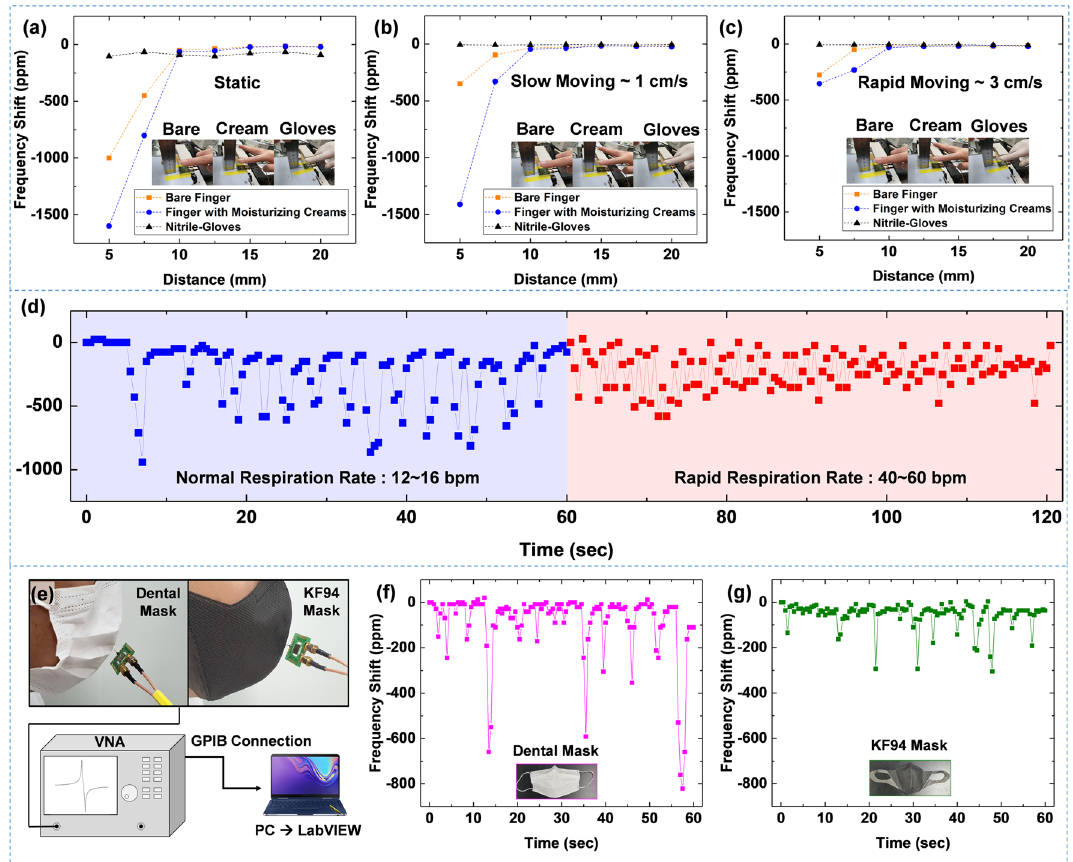
Figure 6. The frequency responses of the SAW 250 MHz_10 min sensor at different distances between the finger and sensor. The three kinds of the finger (i.e. bare finger, finger with moisturizing creams, and finger with nitrile gloves) are prepared. The sensors are tested at different speeds of finger motion, which are ( a ) static, ( b ) slow-moving (1 cm/s), and ( c ) rapid-moving (3 cm/s). ( d ) The monitoring of respiration rates using SAW 250 MHz_10 min sensor. ( e ) The schematic diagram of the experimental setup for testing salvia droplet filtration efficacy with face masks (dental mask and KF 94 mask). The frequency response of SAW 250 MHz_10 min sensor for the respiration with ( f ) dental mask and ( g ) KF 94